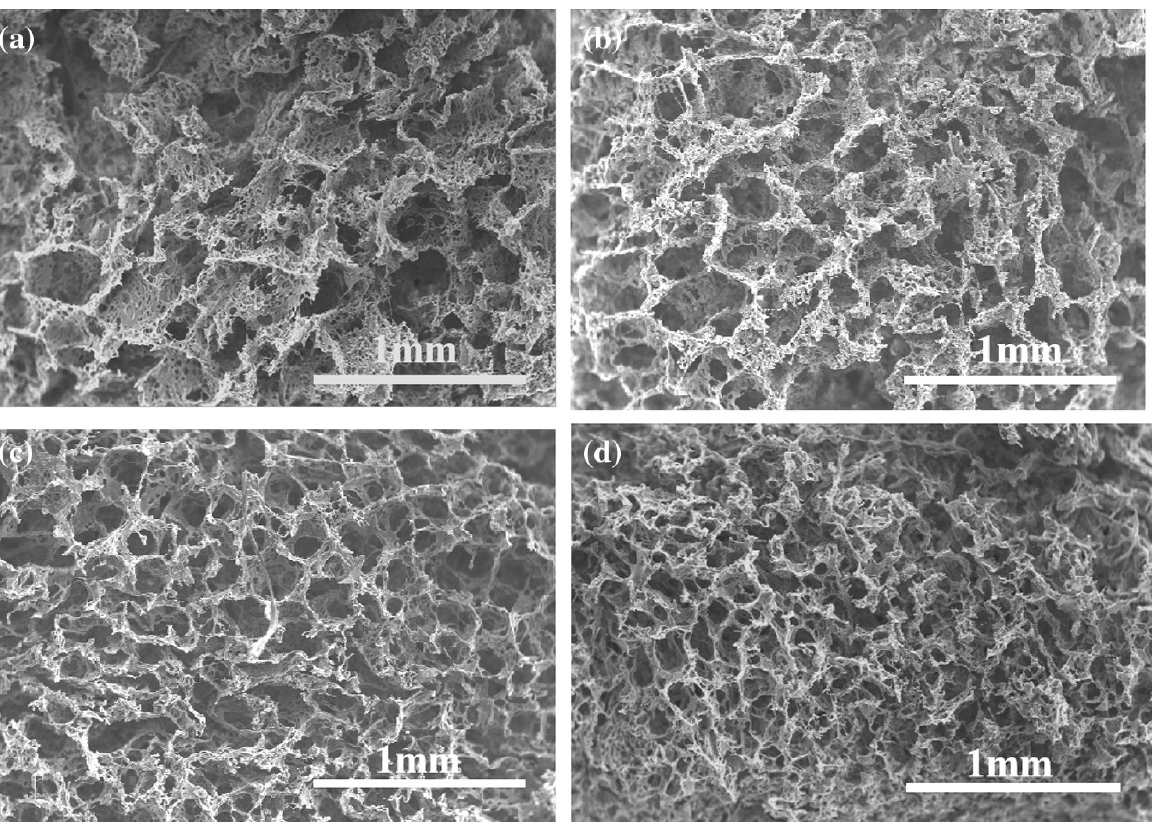
Figure 4. SEM images of vacuum filtration and particle leaching generated PVDF/TPU aerogel com- posites using different sizes of NaCl particles: ( a ) 300–425 µm, ( b ) 212–300 µm, ( c ) 150–212 µm and composites using different sizes of NaCl particles: ( a ) 300–425 µ m, ( b ) 212–300 µ m, ( c ) 150–212 µ m ( d ) 0–150 µm. Reproduced from [3], ©2021 the authors. and ( d ) 0–150 µ m. Reproduced from [3], ©2021 the